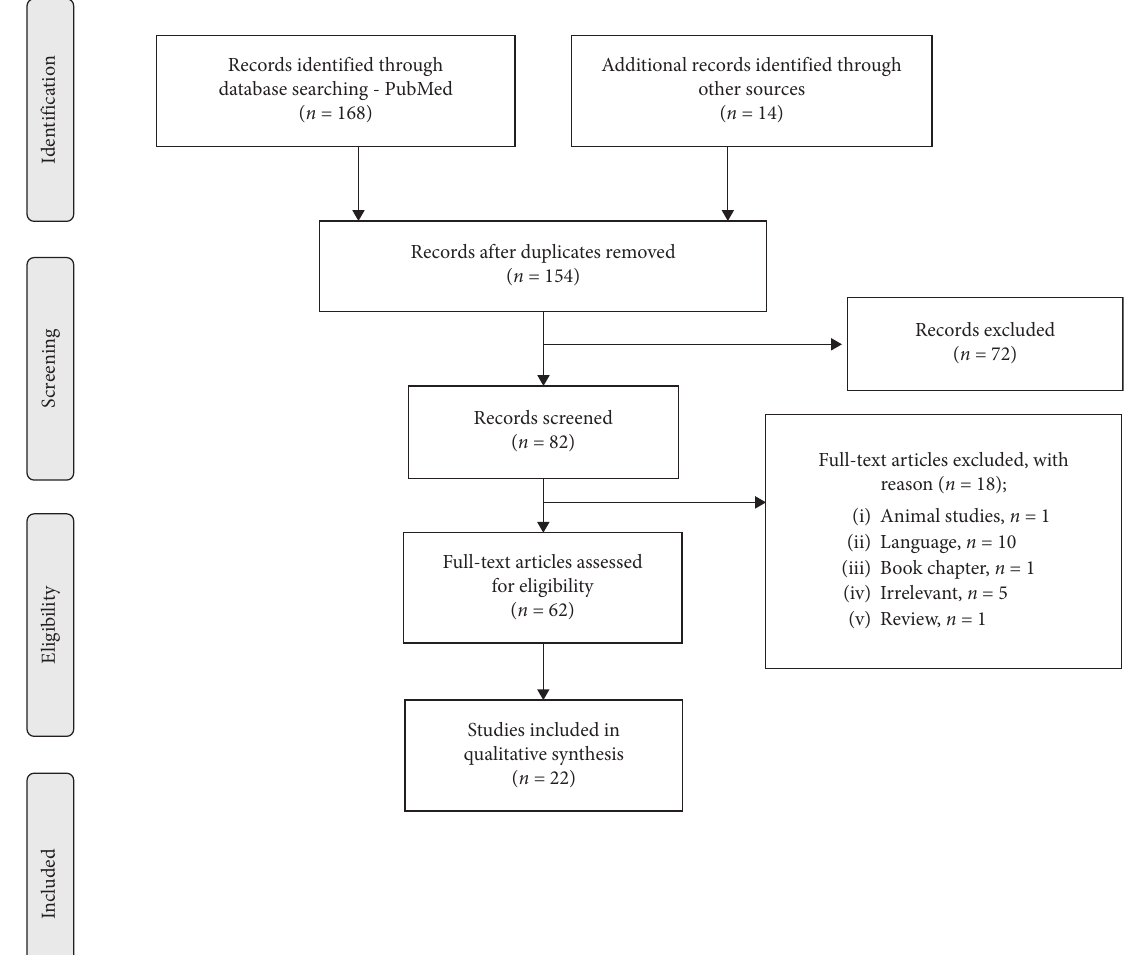
Figure 1: PRISMA flowchart showing the stages of the systematic review. The screening process identified 22 studies from an initial pool of 154 as being relevant to the current review and having satisfied the inclusion